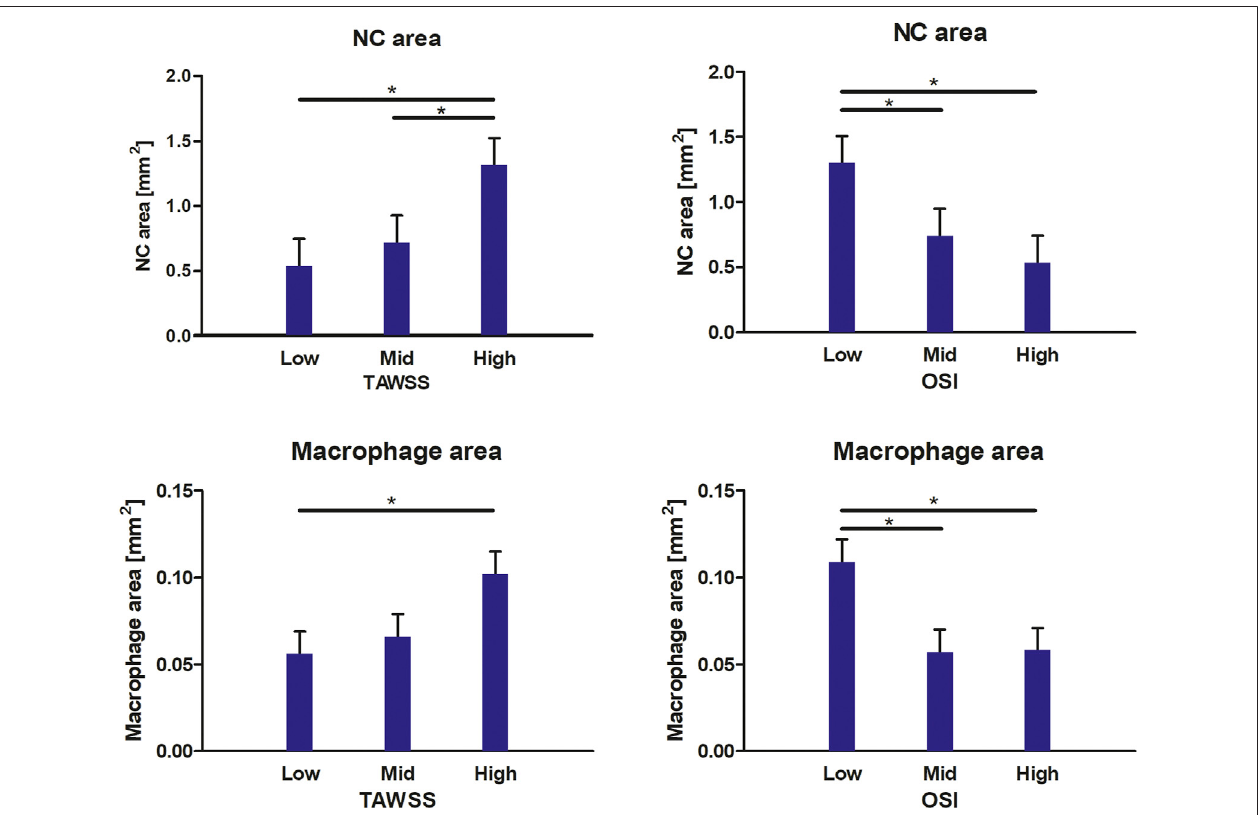
FIGURE3| RelationsbetweenWSSmetricsandplaquecompositionalcharacteristics.InhighTAWSS-exposedregionsandlowOSI-exposedregions,alargerNC area and macrophage area are found. At low TAWSS and low OSI, a larger cap thickness is found. Data are presented as estimated mean +standard error. * p < 0.05.